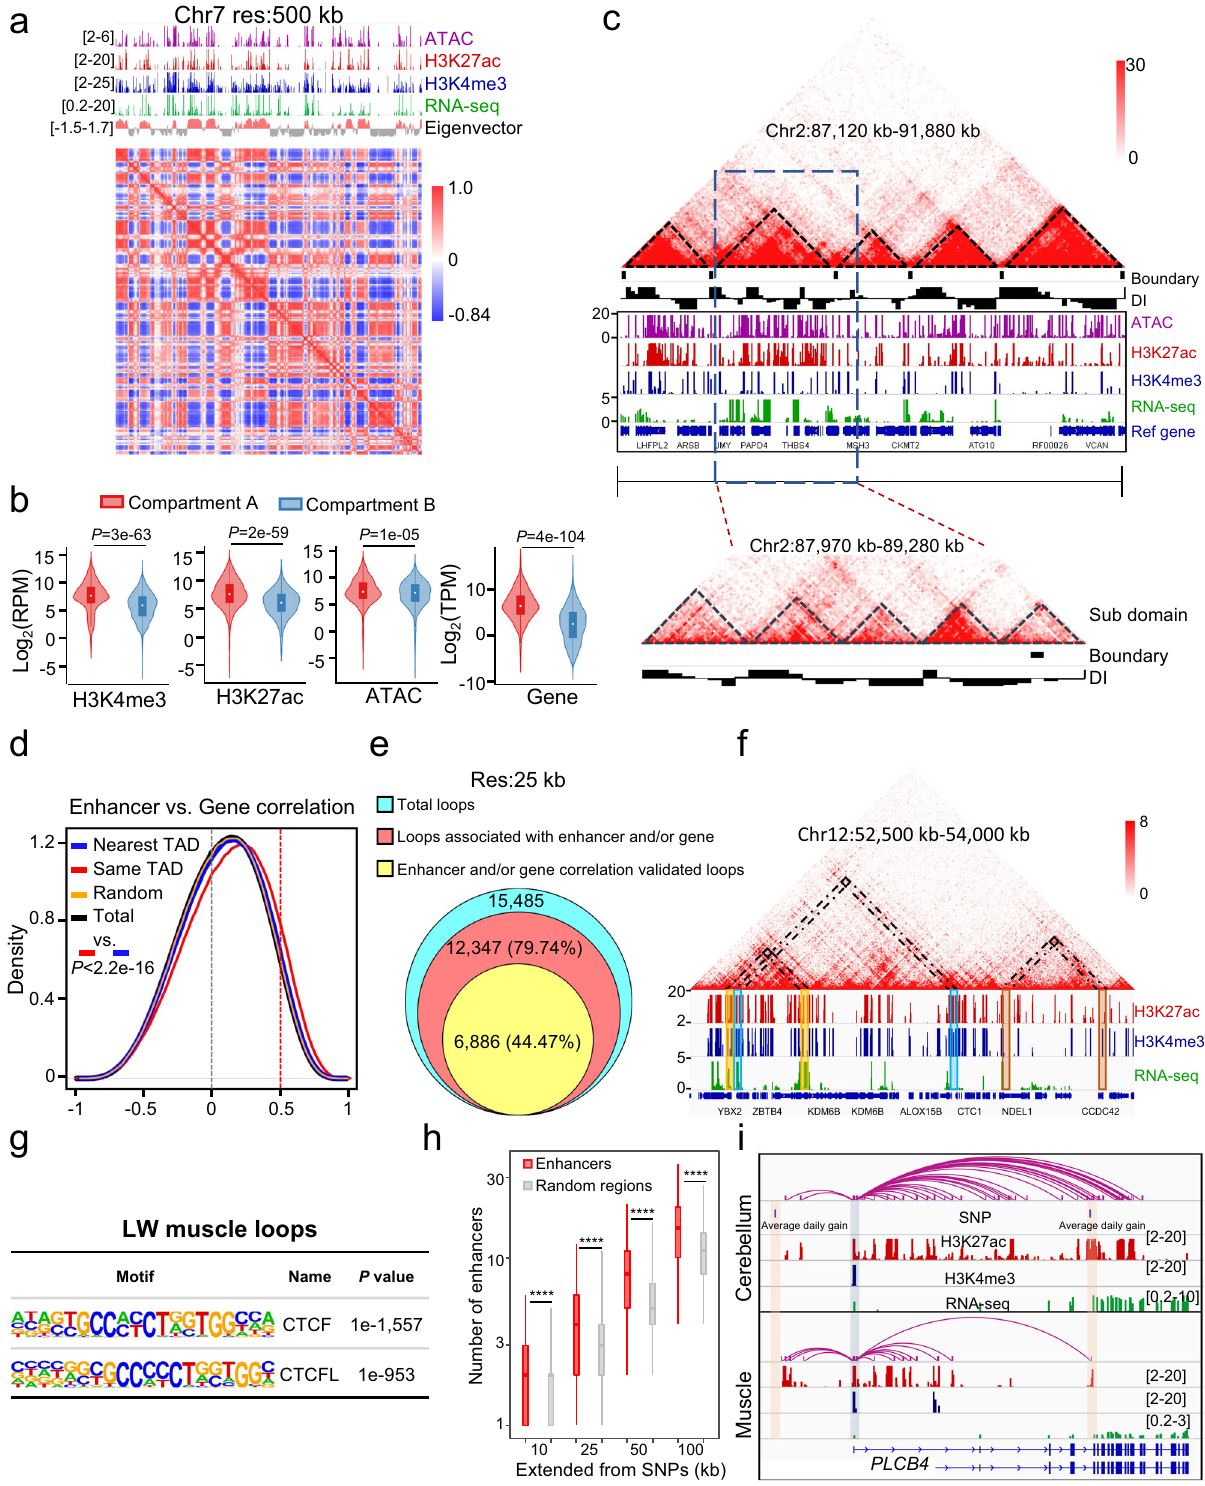
analysis of Hi-C and cis- regulatory element datasets revealed that, at the 25 kb resolution level, 79.74% (12,347) of the loops were associated with cis- regulatory elements, and 44.47% of the loops were validated by the signi fi cantly correlated cis- regulatory elements (Fig. 3e, f). Similar statistical results were obtained at the resolution of 40 kb (Supplementary Fig. 6d). A